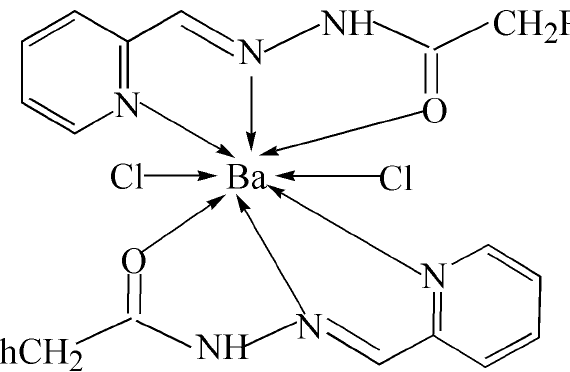
Scheme 1. Chemical diagram of the Ba(II) complex.